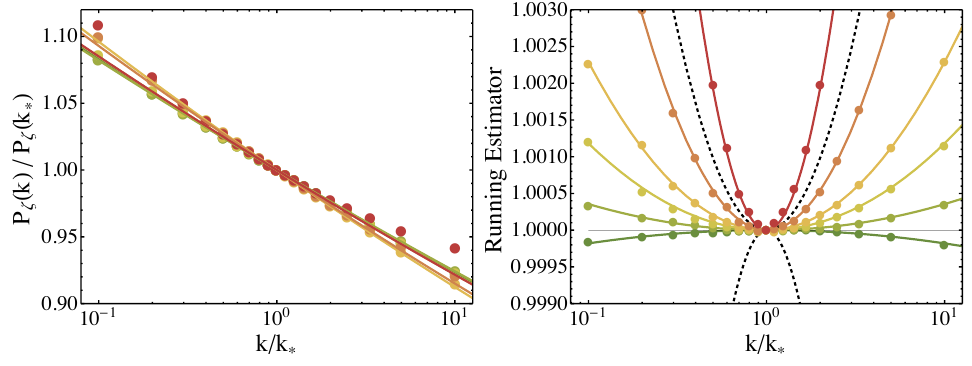
Figure 12 . Left: the normalized scalar power spectrum amplitude as a function of wavenumber for the parameters corresponding to the six dots of (cid:12)gure 11. The lines correspond to power-law (cid:12)ts P (cid:16) ( k ) (cid:24) k n s (cid:0) 1 , while the dots show the results of numerical simulations. Right: the ratio of the normalized tensor amplitude (plotted on the left panel) to the form P (cid:16) ( k ) (cid:24) k n s (cid:0) 1 . The dots correspond to data points while the lines show the best-(cid:12)t parabolae. This is a constant line in the case of zero running of the spectral index, hence it can be used as a visual estimator of the magnitude of the running (cid:11) . The black-dotted lines show the latest Planck limits. The color-coding for both panes follows that of (cid:12)gure 11.